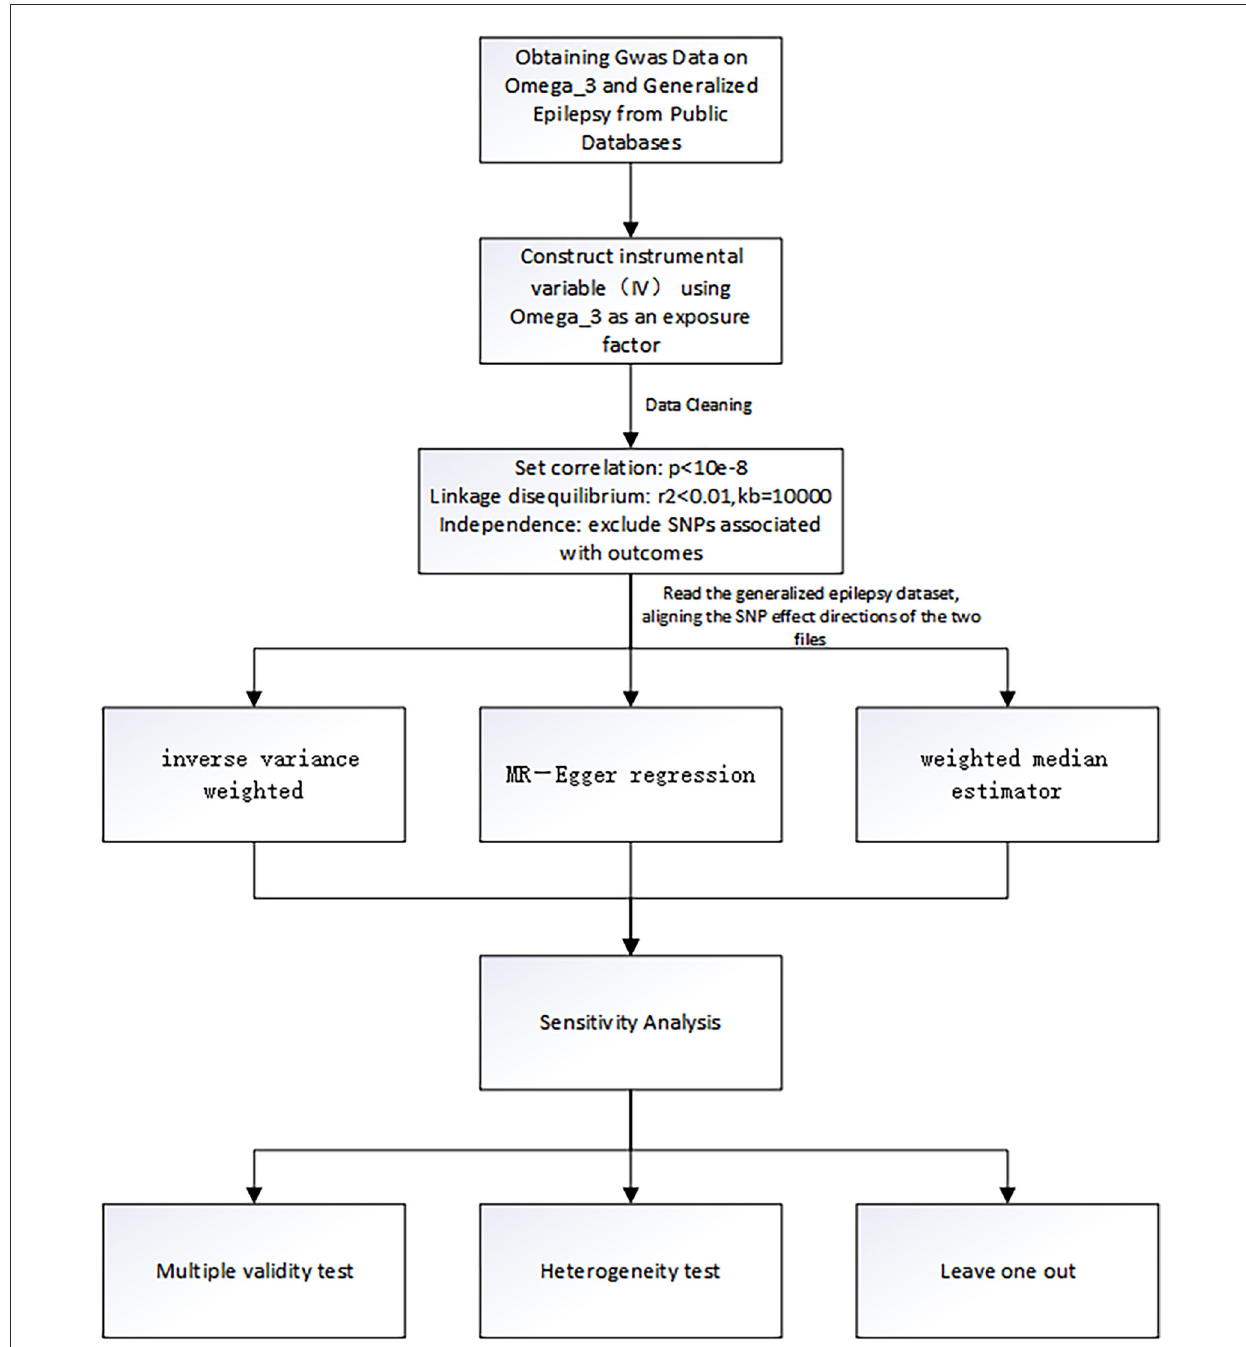
FIGURE1 The flowchart of the study. The whole workflow of MR analysis.